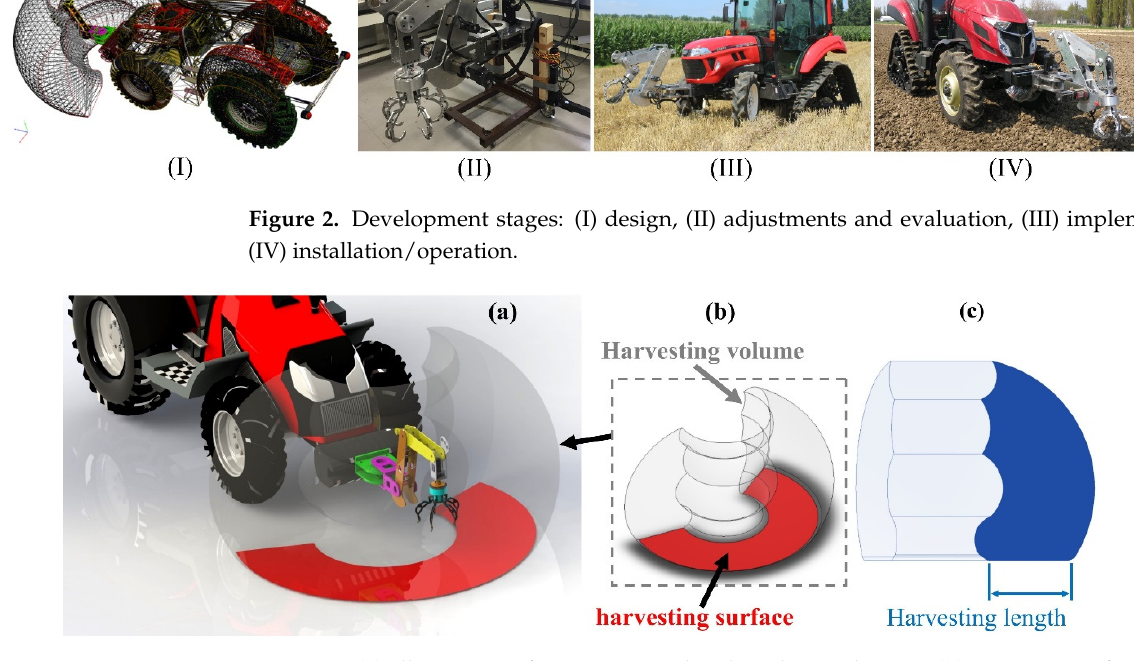
Figure 3. ( a ) Illustration of parameters related to the workspace, ( b ) a 3D view of workspace, ( c ) workspace cross ‐ section.